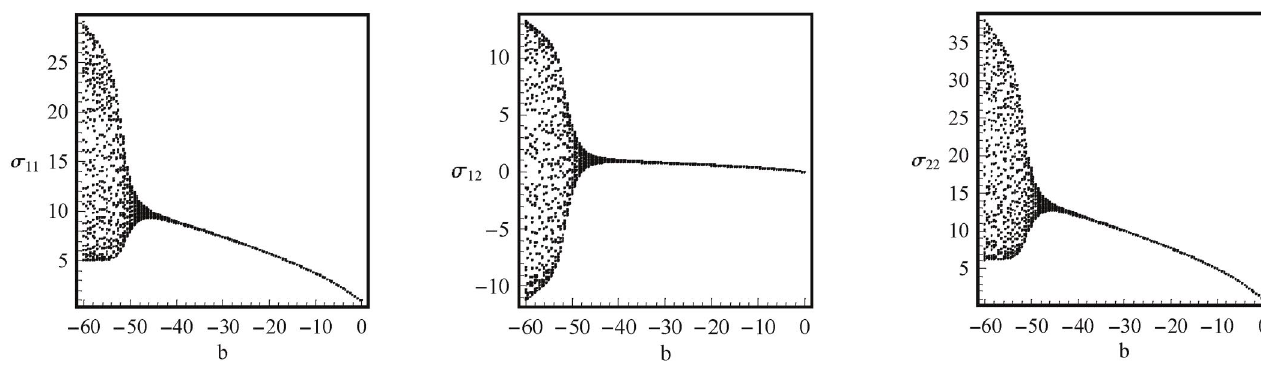
FIG. 2. Gaussian approximation with (cid:3) 0 wake. (cid:22)